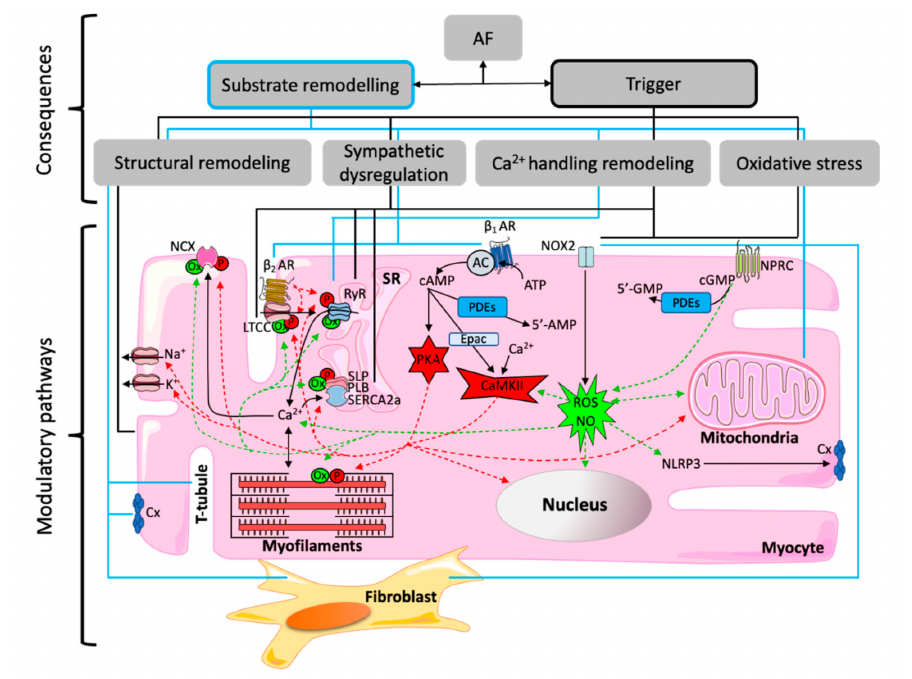
Figure 2. Molecular regulatory networks: Many different microdomains can be modulated by oxida- tion (Ox) via cGMP, reactive oxygen species (ROS) and nitric oxide (NO), or by phosphorylation (P) via cAMP, protein kinase A (PKA) and Ca 2+ -calmodulin dependent protein-kinase type-II (CaMKII). Regulated Ca 2+ -handling microdomains include Na + /Ca 2+ exchanger (NCX) and L-type Ca 2+ chan- nel (LTCC) at the cell membrane, ryanodine receptor (RyR) and sarcoplasmic reticulum Ca 2+ ATPase (SERCA2a), which is inhibited by sarcolipin (SLP) and phospholamban (PLB), at the sarcoplasmic reticulum (SR) membrane, the NOD-, LRR- and pyrin domain-containing protein 3 (NLRP3), and contractile proteins at the myofilaments. PKA/CaMKII are activated by β -adrenoreceptor ( β AR) signaling via adenyl cyclase (AC), phosphodiesterases (PDEs) and exchange protein directly activated by cAMP (Epac). ROS/NO is produced/increased by nicotinamide adenine dinucleotide phosphate (NADPH) oxidase (NOX2) and natriuretic peptide clearance receptor (NPRC). Other modulations of atrial fibrillation-related remodeling are ion channels, such as Na + and K + channels, activation of fibroblasts or structural changes such as dilation or stretch affecting the tubular network, as well as connexins (Cx)